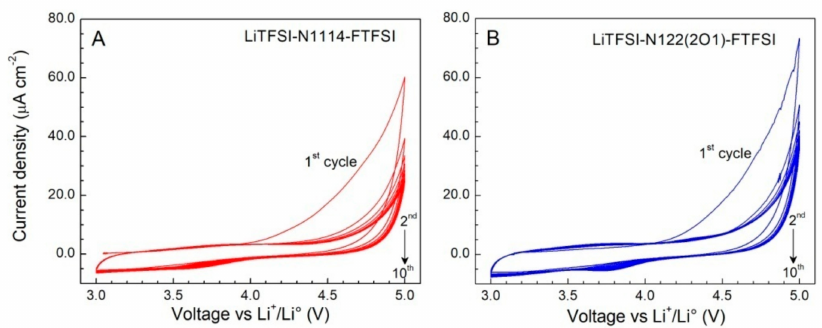
Figure 5. Anodic cyclic voltammetries of the 0.2LiTFSI-0.8N1114-FTFSI (panel ( A )) and 0.2LiTFSI- 0.8N122(2O1)-FTFSI (panel ( B )) ionic liquid electrolytes. Carbon and lithium metal are used as the working electrode and the counter electrode, respectively. Scan rate: 1 mV s − 1 . Temperature: 20 ◦ C. The current density value was obtained by normalizing the current flow with respect to the geometrical surface area of the working